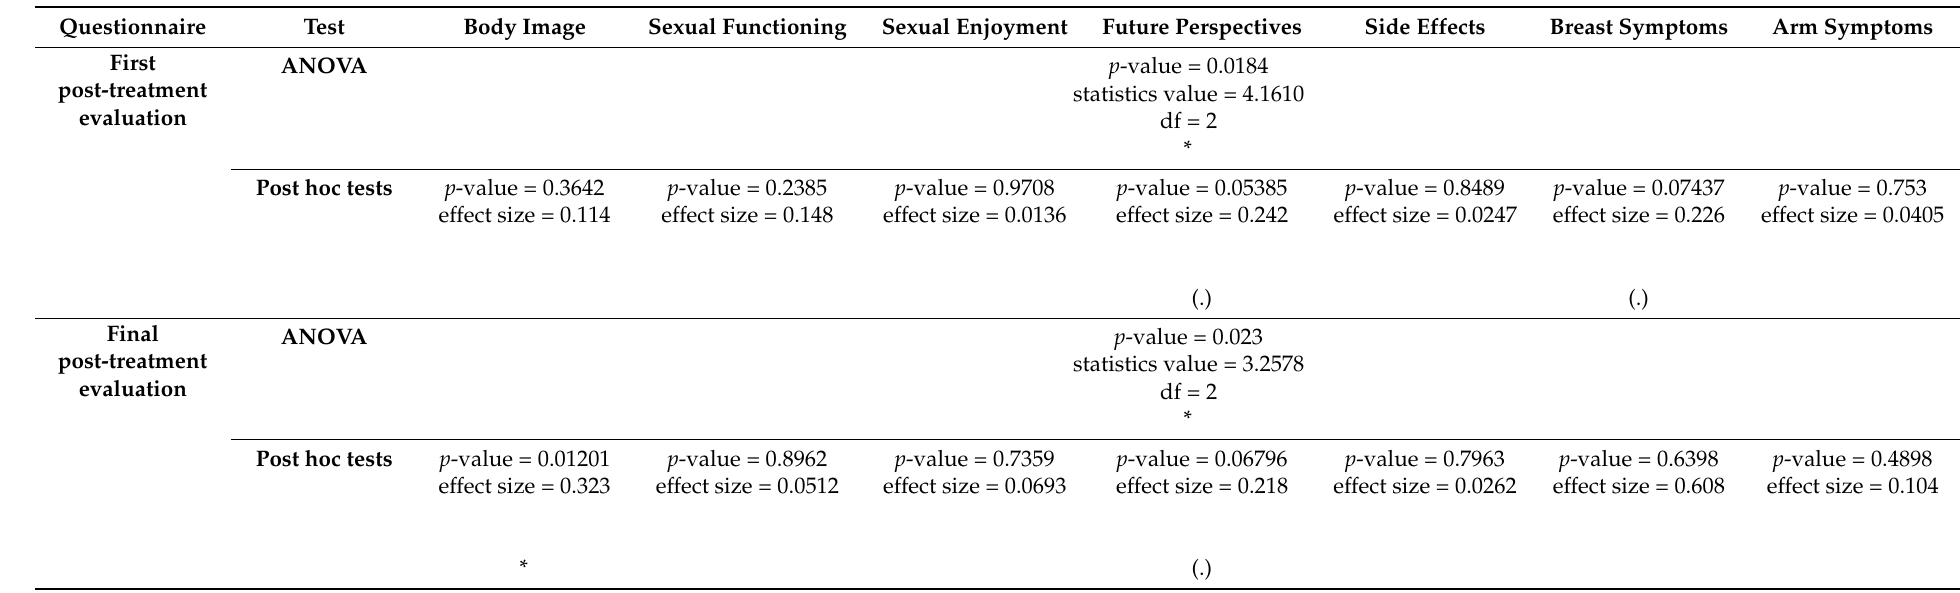
Table A4. Statistical tests performed after baseline correction to compare the hippotherapy and control groups, in order to assess the difference in score evolution for all the QLQ-BR23 items, at first post-treatment evaluation and final post-treatment evaluation. First, a robust between–within participants ANOVA was performed to evaluate as to whether the two therapies were following a different behavior with respect to the QoL items, for each questionnaire (Q2 and Q3). If significant, post hoc tests (two-sided Wilcoxon) were performed for each item to determine statistical differences between the two groups. (.) close to significance (between 0.08 and 0.05); (*) p <